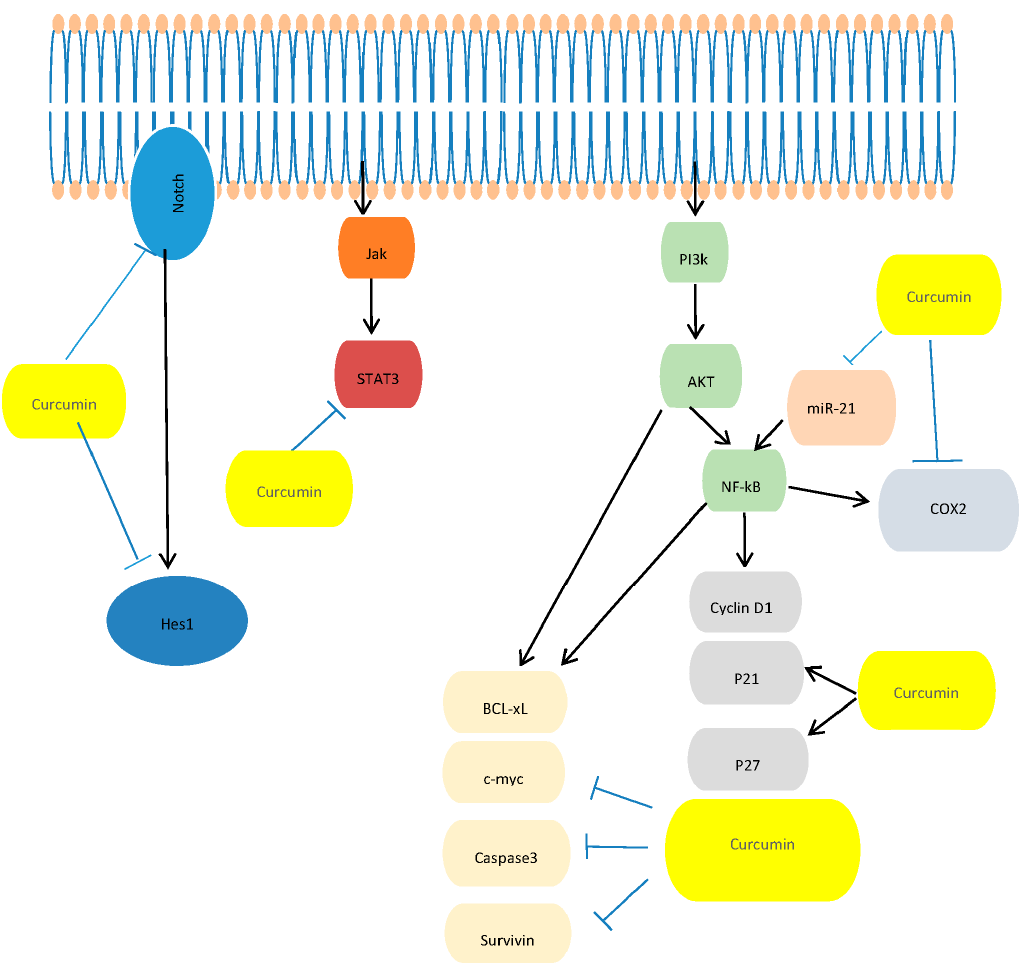
Figure 1. A schematization of molecular targets in PC regulated by curcumin. NF ‐κ B: Nuclear factor kappa ‐ light ‐ chain ‐ enhancer of activated B cells; COX2: Cyclooxygenase 2; Hes ‐ 1: Cyclin ‐ dependent kinase 1; Akt: Protein kinase B; Stat3: Signal transducer and activator of transcription 3; PI3K: